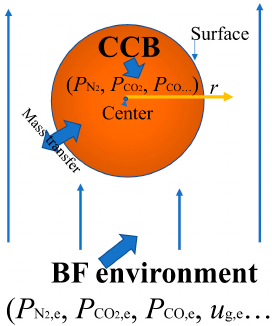
Figure 2. Concept of the CCB reaction model in the BF environment. Table 2. Reactions involved in the model.